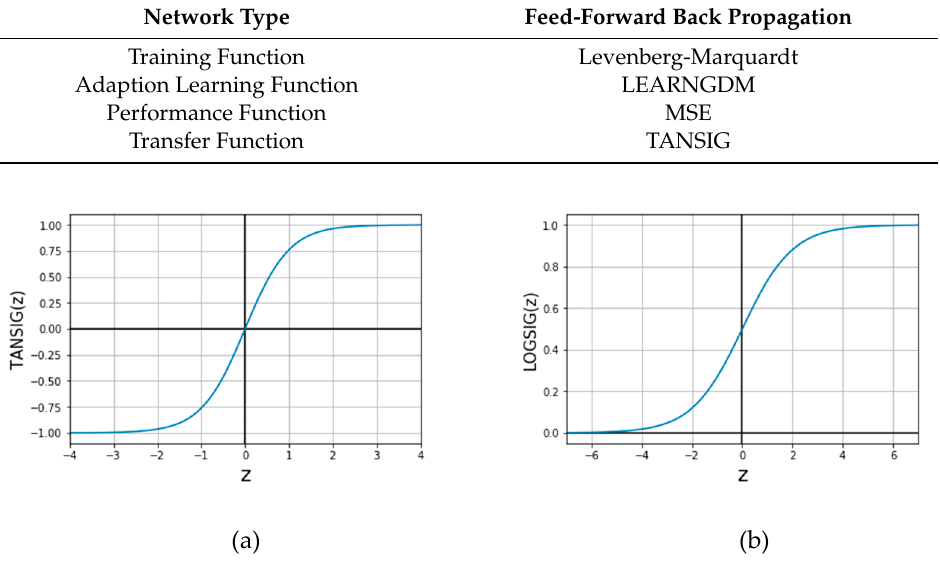
Figure 5. Transfer functions: ( a ) tangent sigmoid function (TANSIG), ( b ) log sigmoid (LOGSIG).